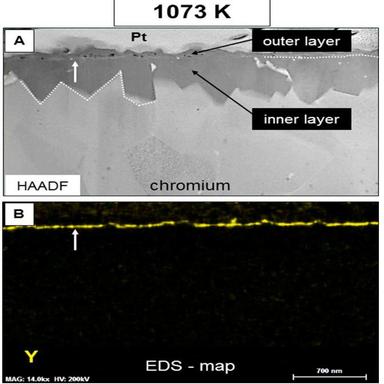
(A) - STEM-HAADF image of the scale formed on chromium implanted with yttrium ions (2 × 1016 Y/cm2 ) after 100 h of oxidation in air at 1073 K; (B) - STEM-EDS elemental distribution map of yttrium for the investigated area.